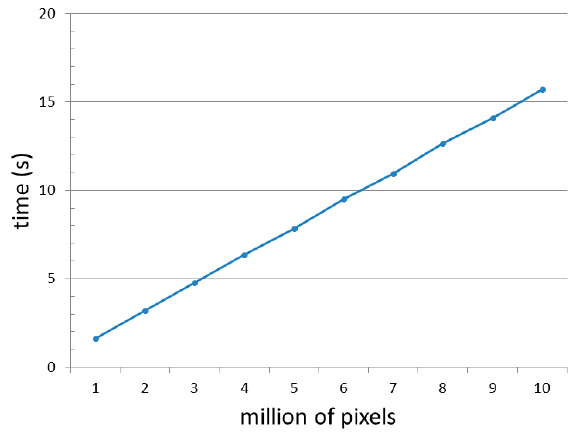
Figure 5. Runtime (in seconds, vertical axis) comparison for generating SLIC superpixels for a QuickBird image with 4 bands and extent ranging from 1 to 10 million pixels, with an increment of 1 (horizontal axis).